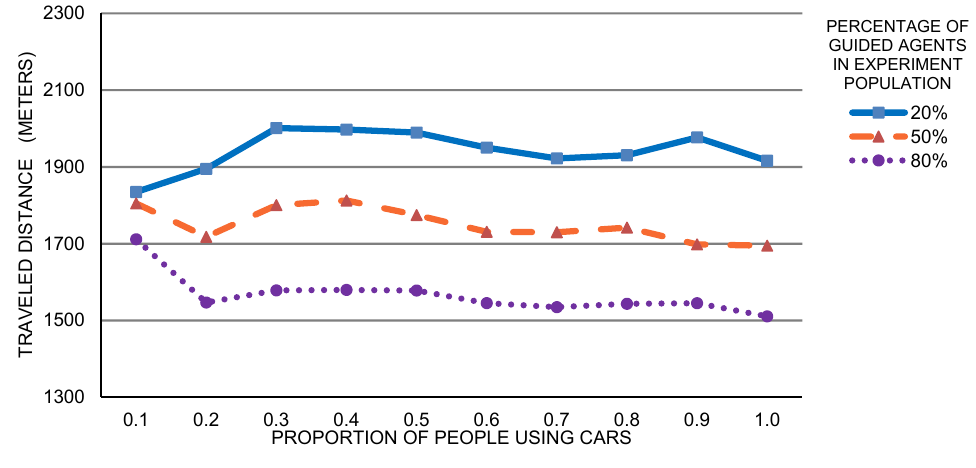
Figure 4. Variation of the mean traveled distance.